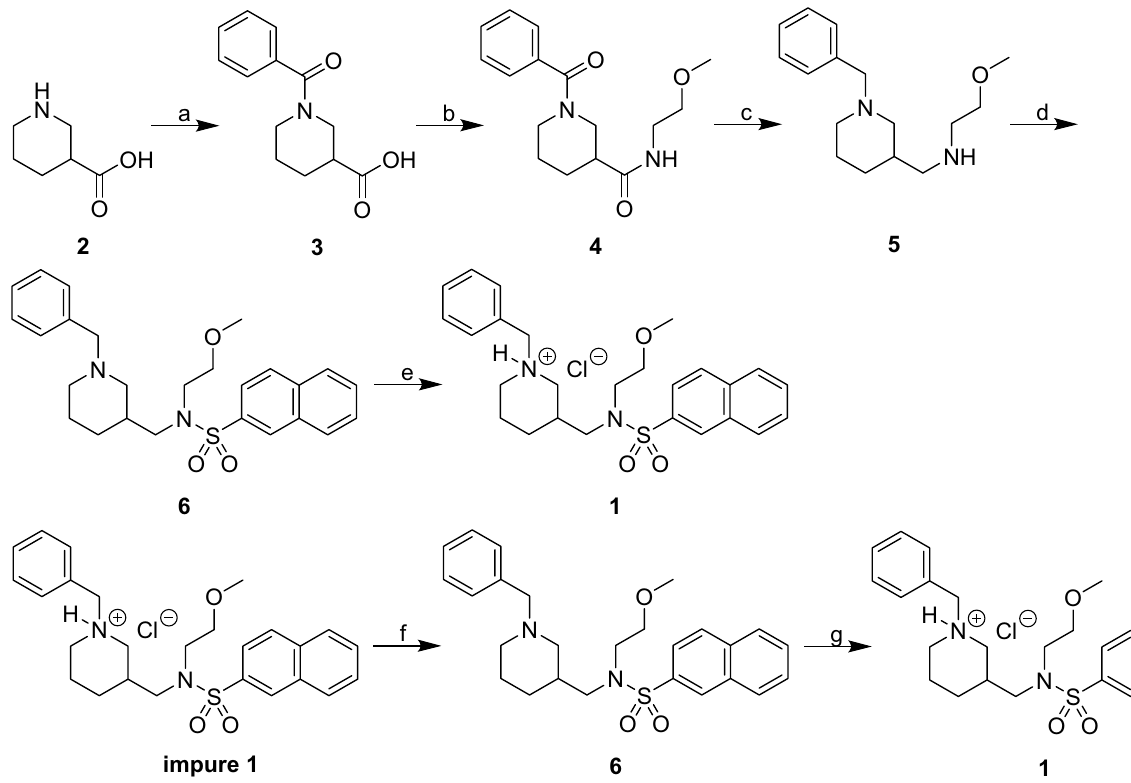
Figure 4. Synthesis of compound. Reagents and conditions: ( a ) (i) BzCl, K 2 CO 3 , THF/H2O, 0 °C to room temperature, 24 h, (ii) 6 M HCl (aq) to pH 1–2, 0 °C, 2 h (93%); ( b ) H 2 N(CH 2 ) 2 OMe, TBTU, Et 3 N, CH 2 Cl 2 , 0 °C to room temperature, 24 h (86%); ( c ) LiAlH4, dry THF, room temperature to reflux, under Ar (g) , 3.5 h (93%); ( d ) naphthalene-2-sulfonyl chloride,